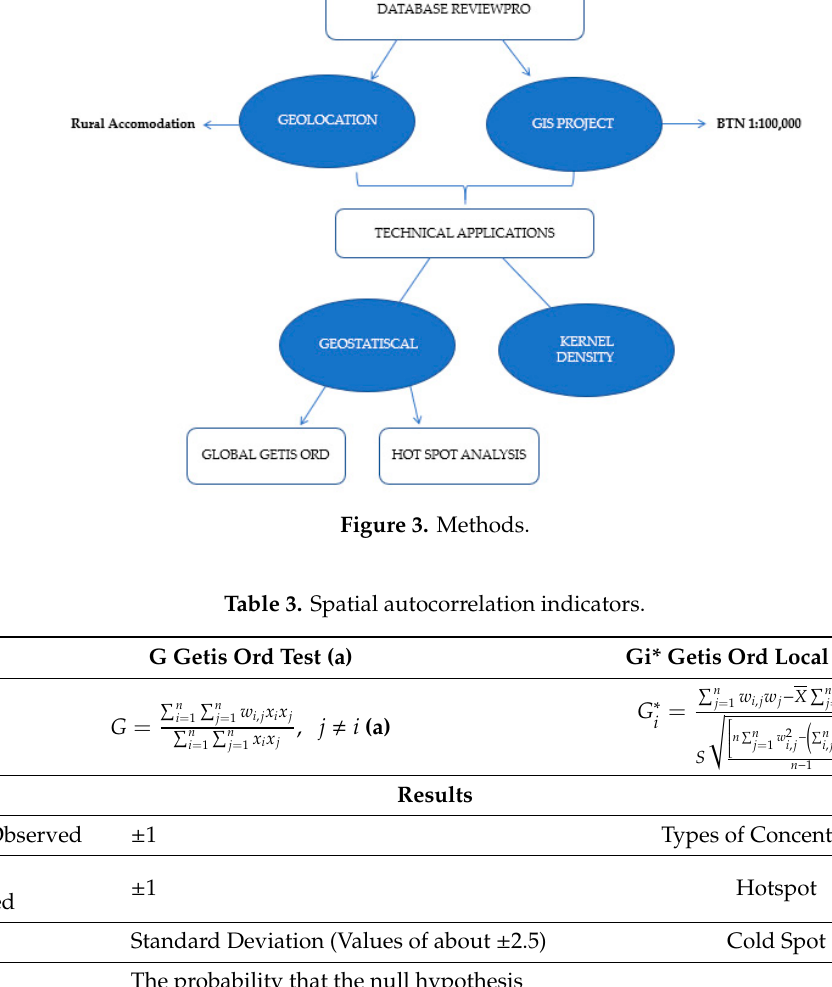
Table 3. Spatial autocorrelation